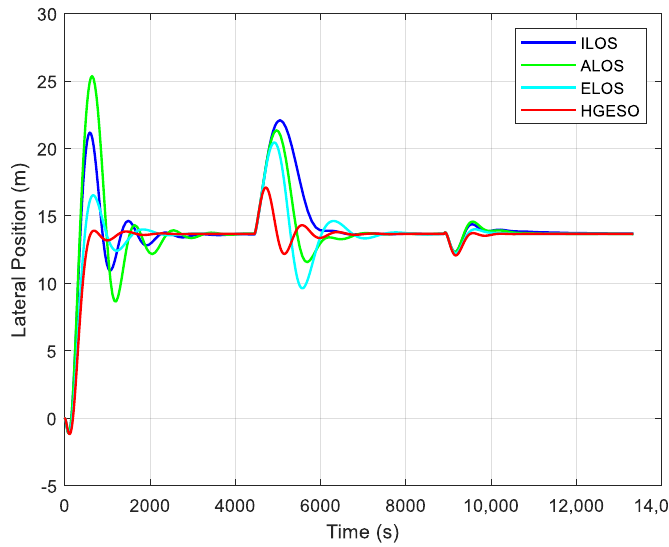
= 0.1 L y . Figure 4. Comparison of lateral position with different guidance laws at y d d